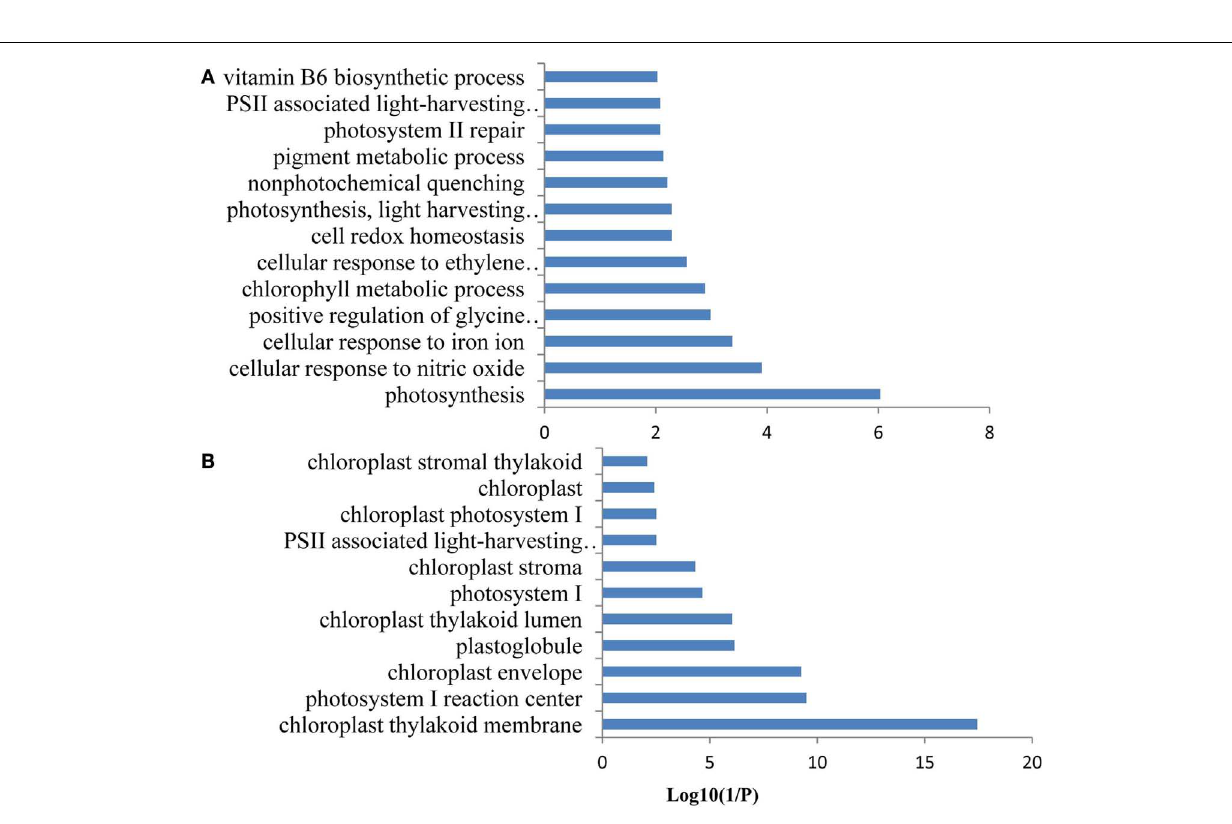
FIGURE 8 | Gene ontology (GO) enrichment analysis of the genes from FEPKPP3 . GO enrichment of the 36 Fe-responsive genes in the module FEPKPP3 was performed with the GOBU toolbox using theTopGo “elim” method with P < 0.01. (A) GO biological process and (B) GO subcellular